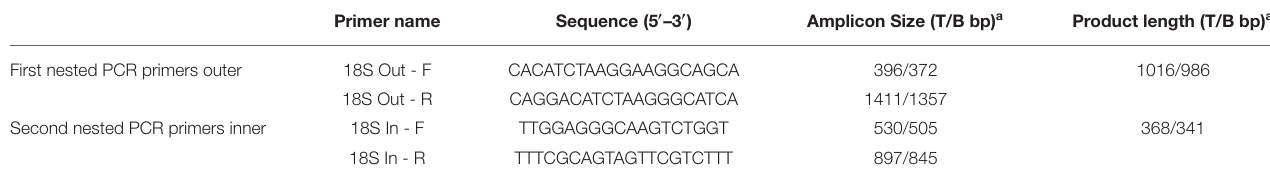
TABLE 1 | Primer sequences of nested PCR for detecting T. equi and B. caballi .